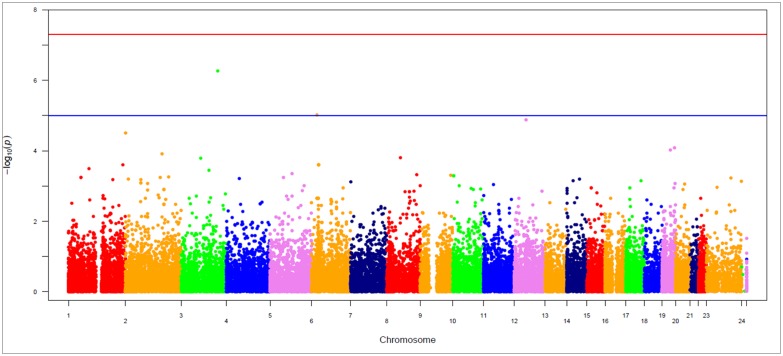
Manhattan plot of association for pathologic Gleason score upgrading in low risk prostate cancer from an analysis of 242,221 single nucleotide polymorphisms on a custom HumanExome BeadChip v1.0 (Illuminam Inc.).The blue line represents p = 1×10−5.